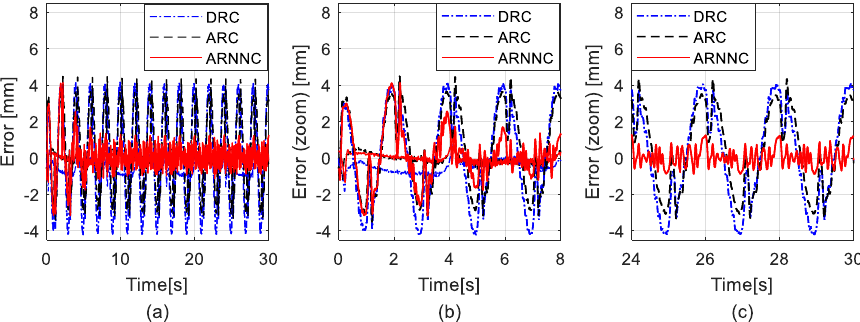
Figure 7. Tracking performances of 90Sin ( π t − 0.5 π ) ( a ) Tracking errors of di ff erent controllers. ( b ) Zoomed tracking errors from 0 to 8 s. ( c ) Zoomed tracking errors from 24 to 30 s.